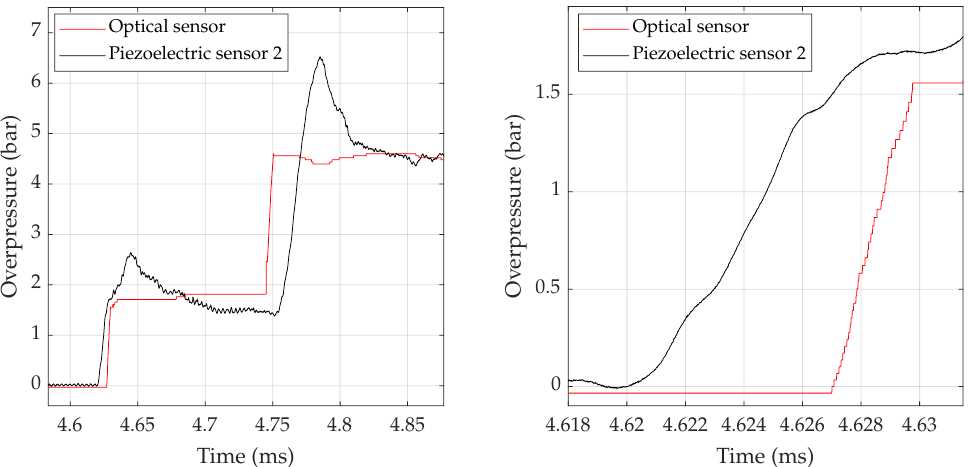
Figure 2. Comparison between an SMI sensor computed pressure change (red solid line) and the piezoelectric sensor 2 (black solid line). Zoom on the steps of pressure P 2 and P 5 ( left plot). Close-up of the first rise ( right